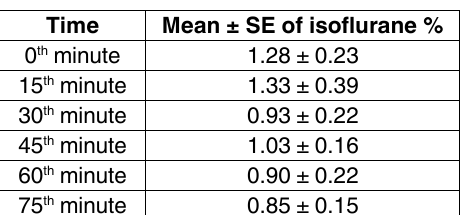
Table 1. Mean concentration (per cent) of isoflurane used to maintain anaesthesia at different time